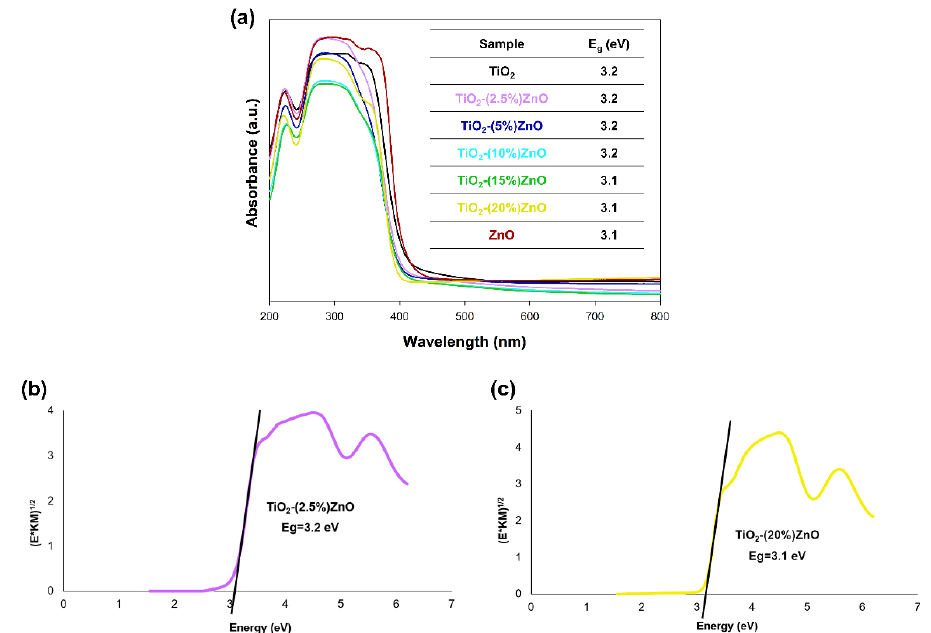
Figure 9. The absorption spectra of TiO 2 -ZnO systems and reference samples ( a ) and Kubelka − Munk function (E*KM) 1/2 as a function of the photon energy of ( b ) TiO 2 -(2.5%)ZnO and ( c ) TiO 2 -(20%)ZnO samples.